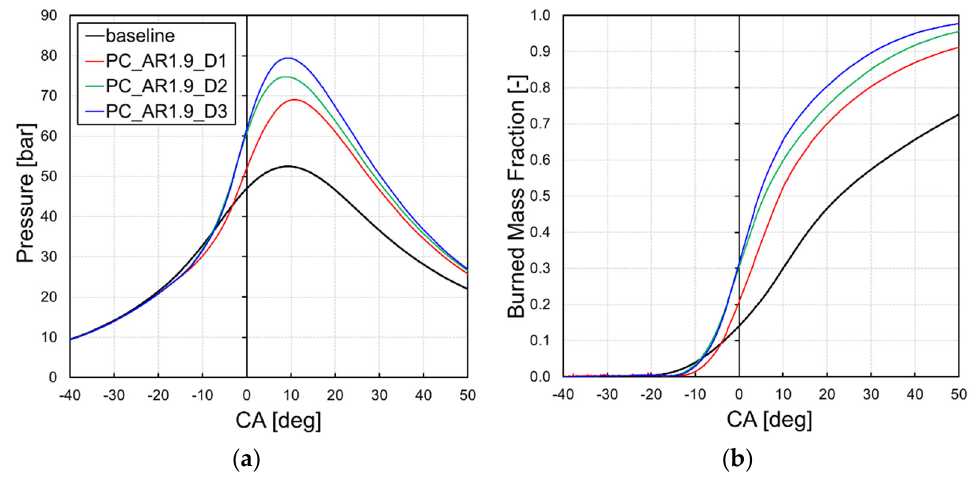
Figure 17. Influence of the orifice diameter on the ( a ) in-cylinder pressure trend and ( b ) burned mass fraction evolution with air-fuel equivalence ratio of 1.2.